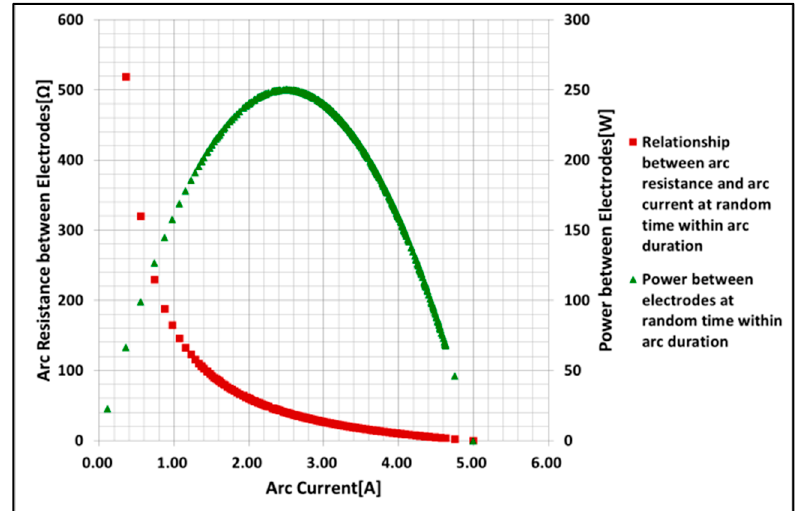
Figure 17. Power between electrodes at 200 V/5 A.